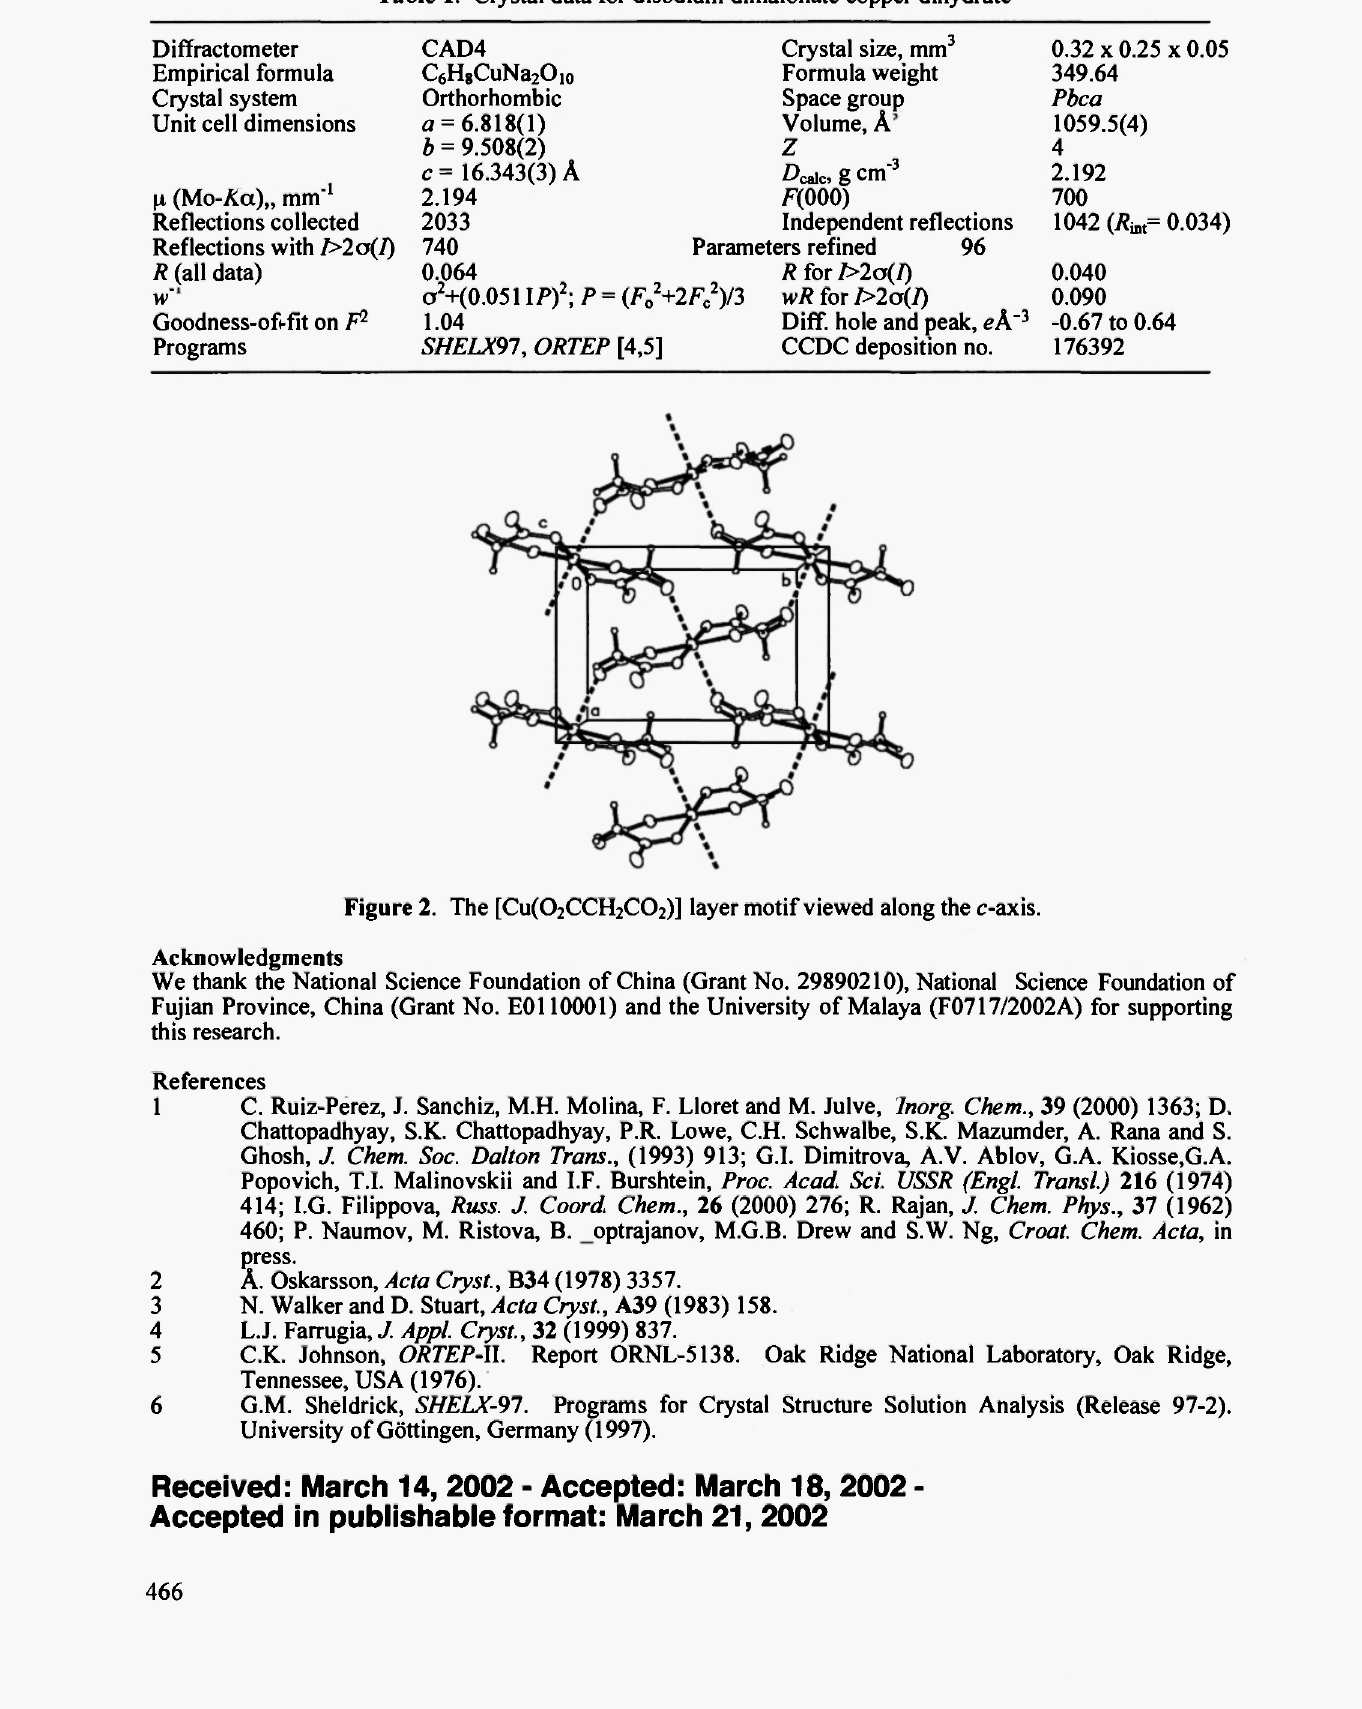
Table 1. Crystal data for disodium dimalonate copper dihydrate